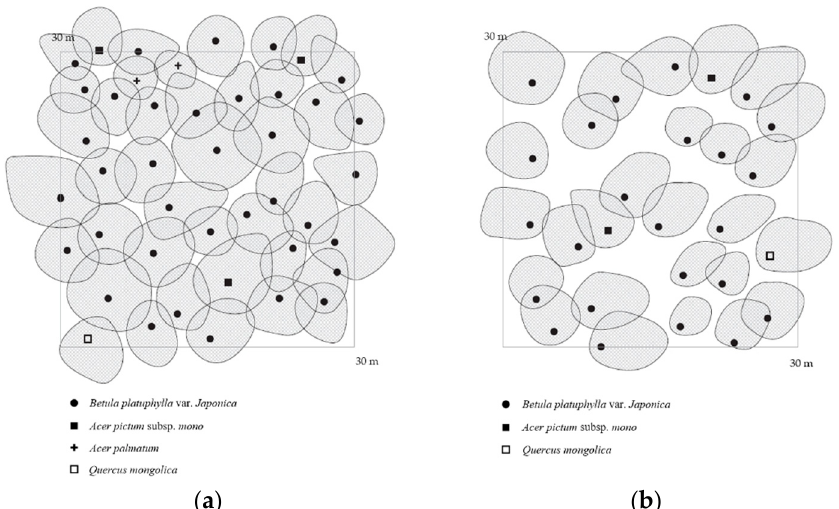
Figure 2. The crown projection of research stands: ( a ) crown density: 90%, ( b ) crown density: 75%.